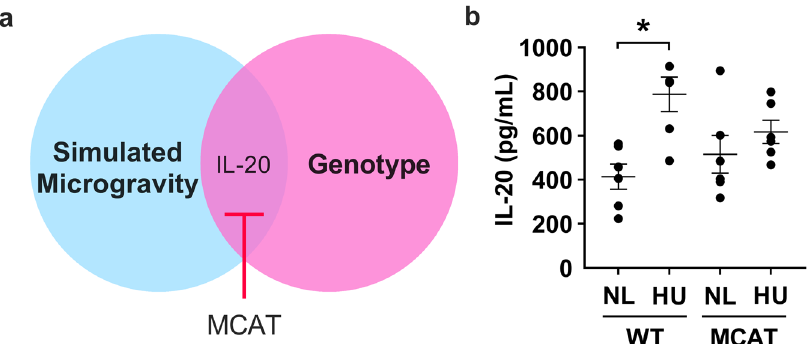
Fig. 6 Effect of simulated microgravity (without isolation) and genotype on the expression of plasma cytokines (social housed groups only). a One cytokine, IL-20, was elevated due to HU in plasma of social housed mice and this effect is mitigated in MCAT animals. b Graph showing protein expression of IL-20 in plasma of WT and MCAT animals exposed to HU. Sample size is n = 6/group. Some data points overlap. *Statistically signi fi cant at p < 0.05 by two-way ANOVA and Tukey post hoc test.